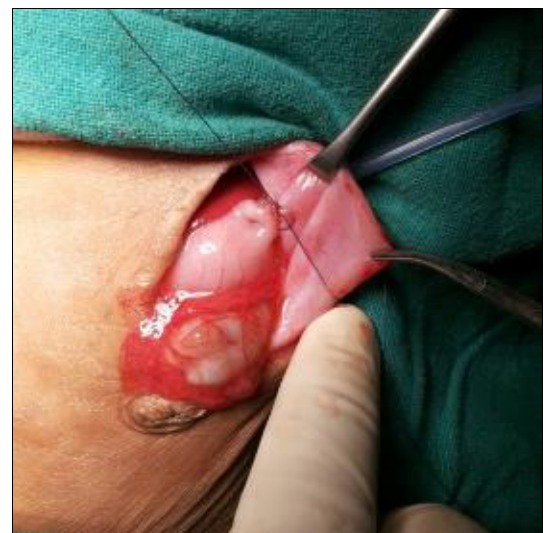
Figure 3: Needle ends used to anchor stomach with the inner abdominal wall just near gastrostomy tube insertion